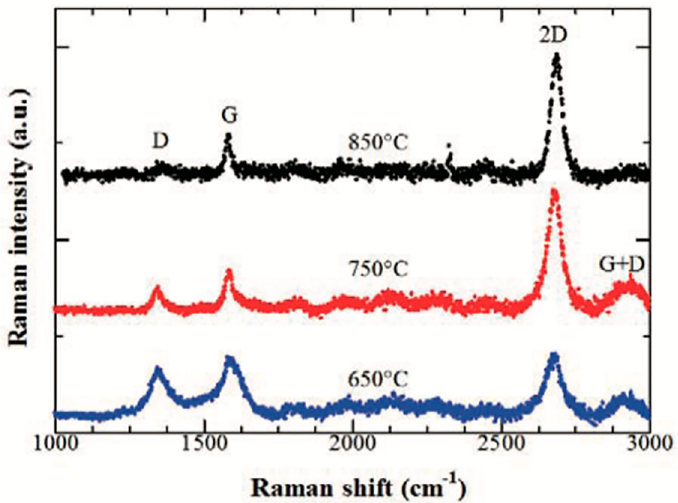
Figure 8. Raman spectra of the CVD grown graphene samples as a function of temperature (reprinted with permission from [79]).